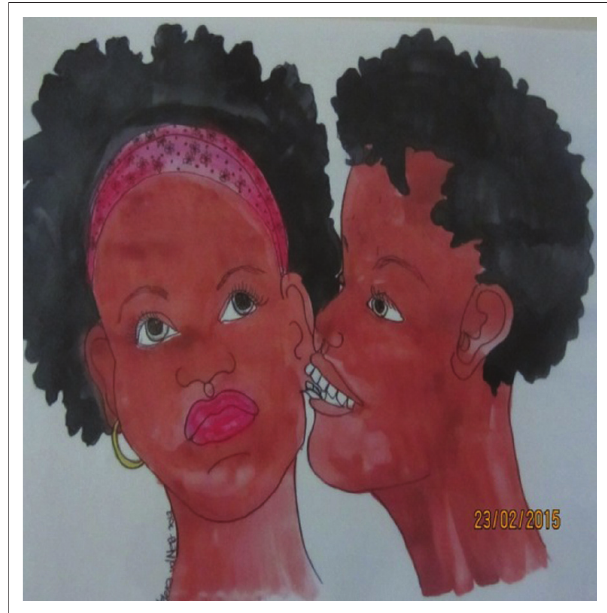
FIGURE 7: Boy biting a girl’s ear.